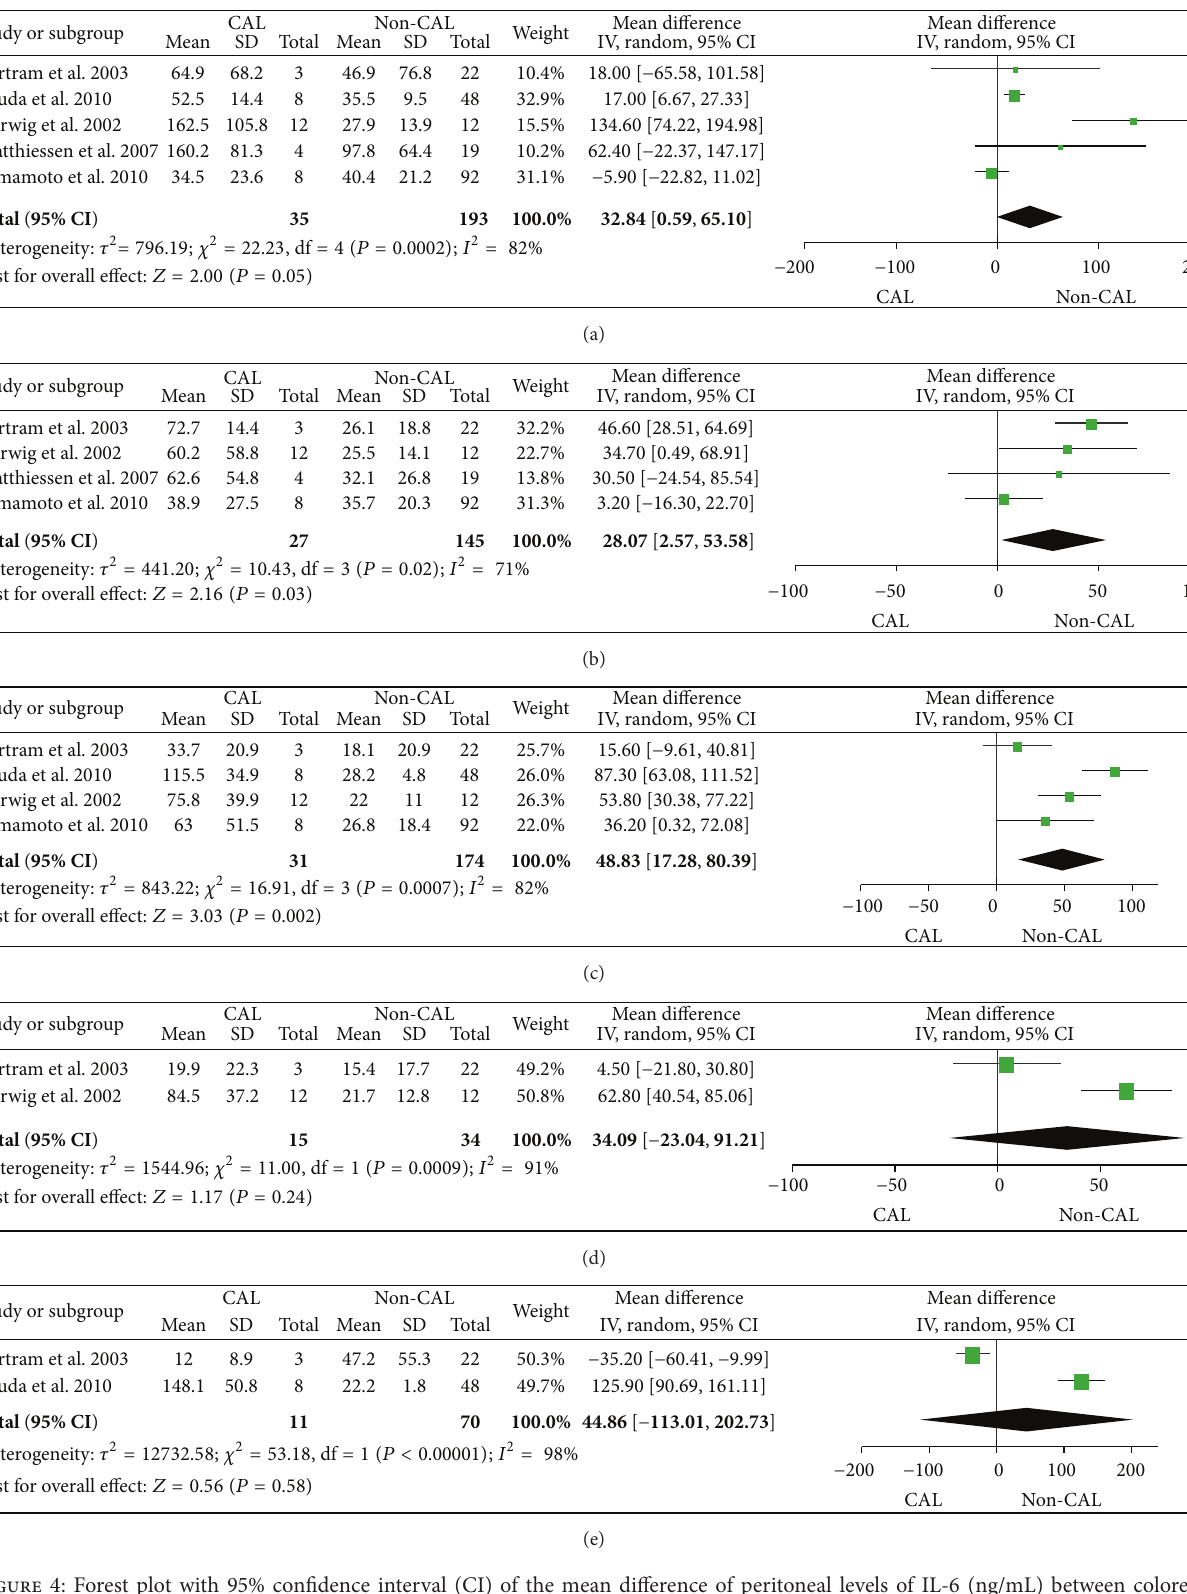
Figure 4: Forest plot with 95% confidence interval (CI) of the mean difference of peritoneal levels of IL-6 (ng/mL) between colorectal anastomotic leakage (CAL) patients and non-CAL patients per postoperative days (POD) 1 (a), 2 (b), 3 (c), 4 (d), and 5